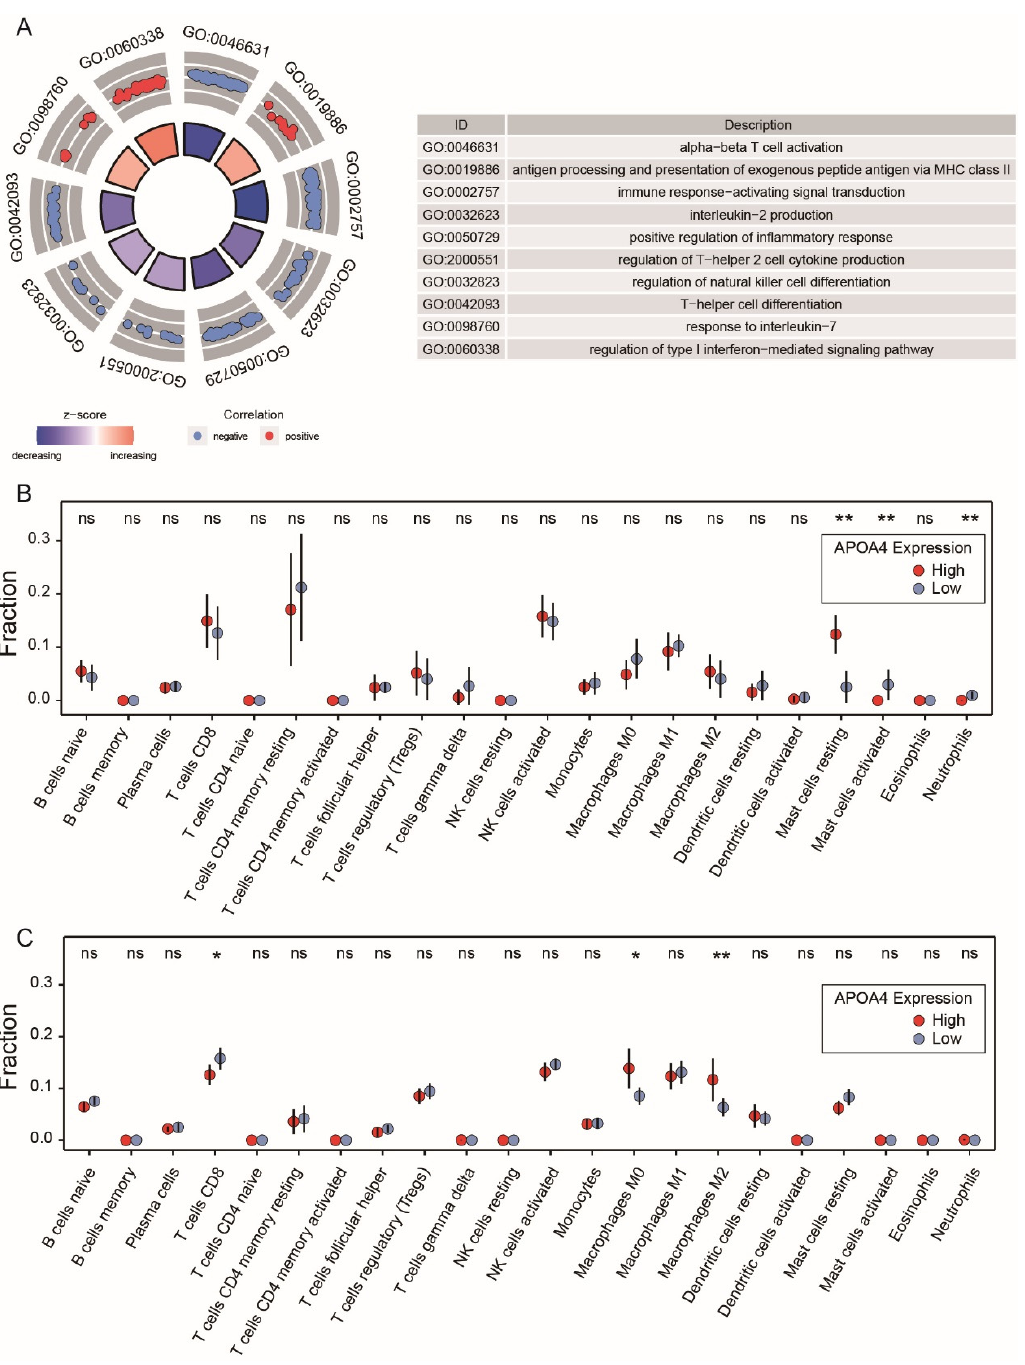
Figure 6. Proportions of 22 immune infiltrating cells’ subpopulations in normal liver tissues and AH tissues were associated with APOA4. ( A ) Analysis of Gene Ontology associated with APOA4 expression by GSEA enrichment analysis. ( B ) Immune infiltrating cells in normal liver tissues. ( C ) Immune infiltrating cells in AH tissues. * p < 0.05, ** p < 0.01 vs. the high group, ns p > 0.05 vs the high group.